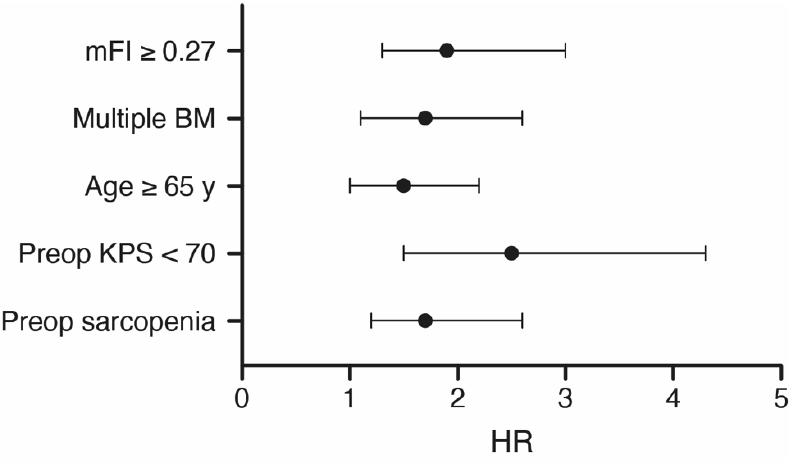
Figure 4. Results from the multivariate analysis. BM, brain metastasis; HR, hazard ratio; KPS, Karnofsky’s performance status; mFI, mean frailty index; y, years.